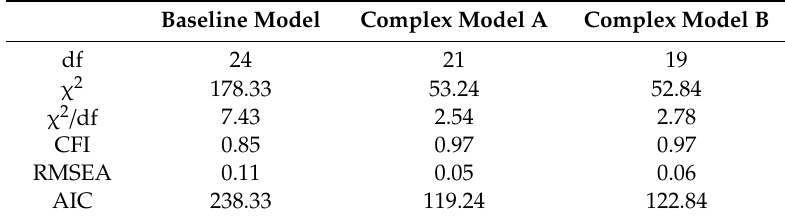
Table 3. Model fit of the SEM analyses.